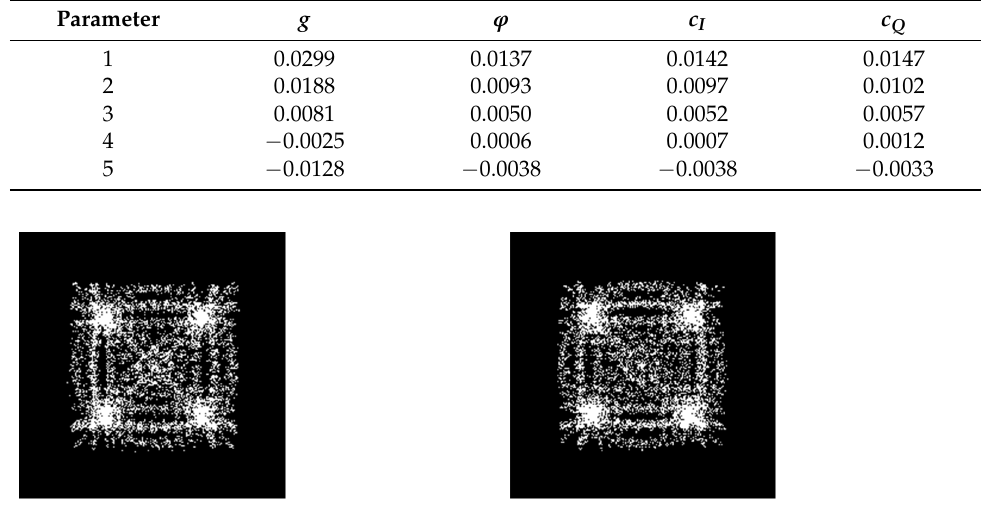
Figure 4. Constellation trace figures.